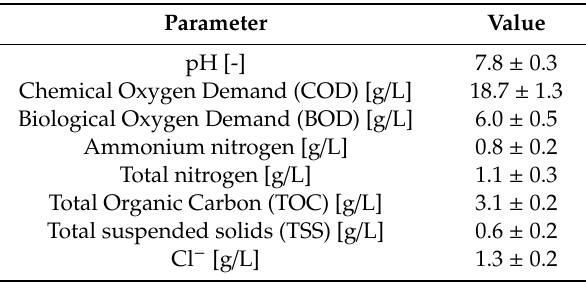
Table 5. The industrial wastewater